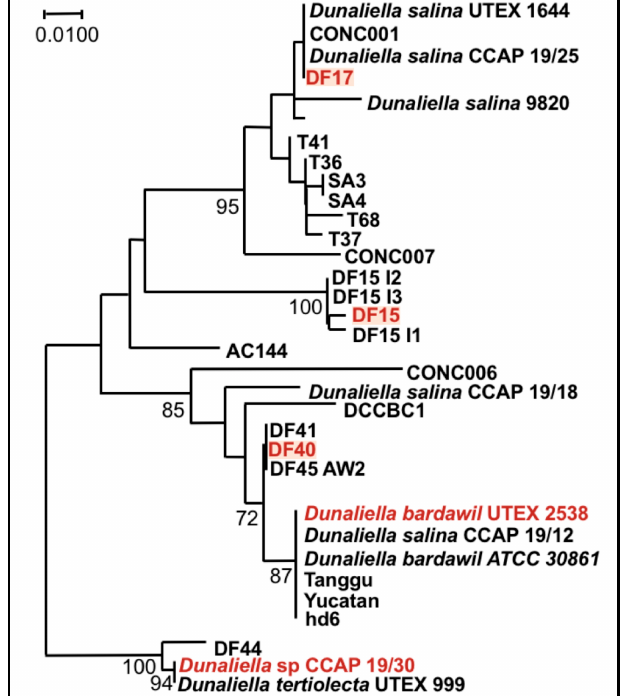
Figure 10. Phylogenetic tree showing the location of the three newly isolated Dunaliella strains (DF15, DF17, and DF40) compared to CCAP 19/30 and UTEX 2538 used in this study [44].